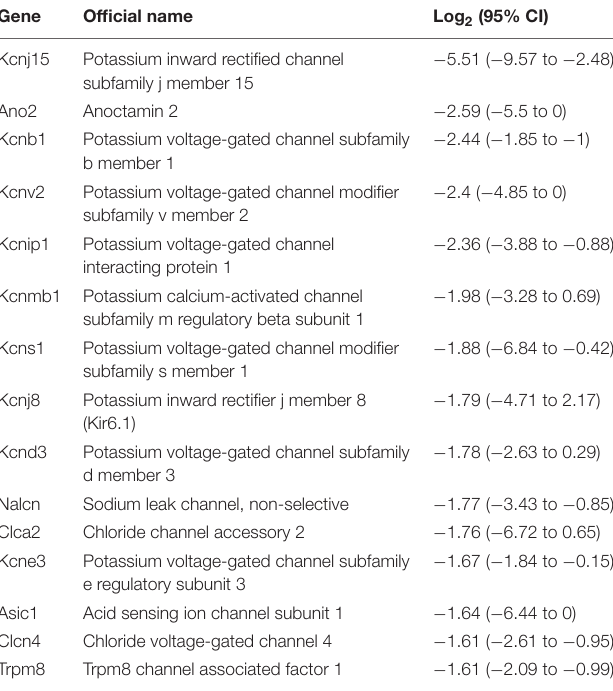
TABLE 1 | FLS channel gene RNA expression lower after cytokine (10 ng/ml TNF α and IL1 β ) treatment.